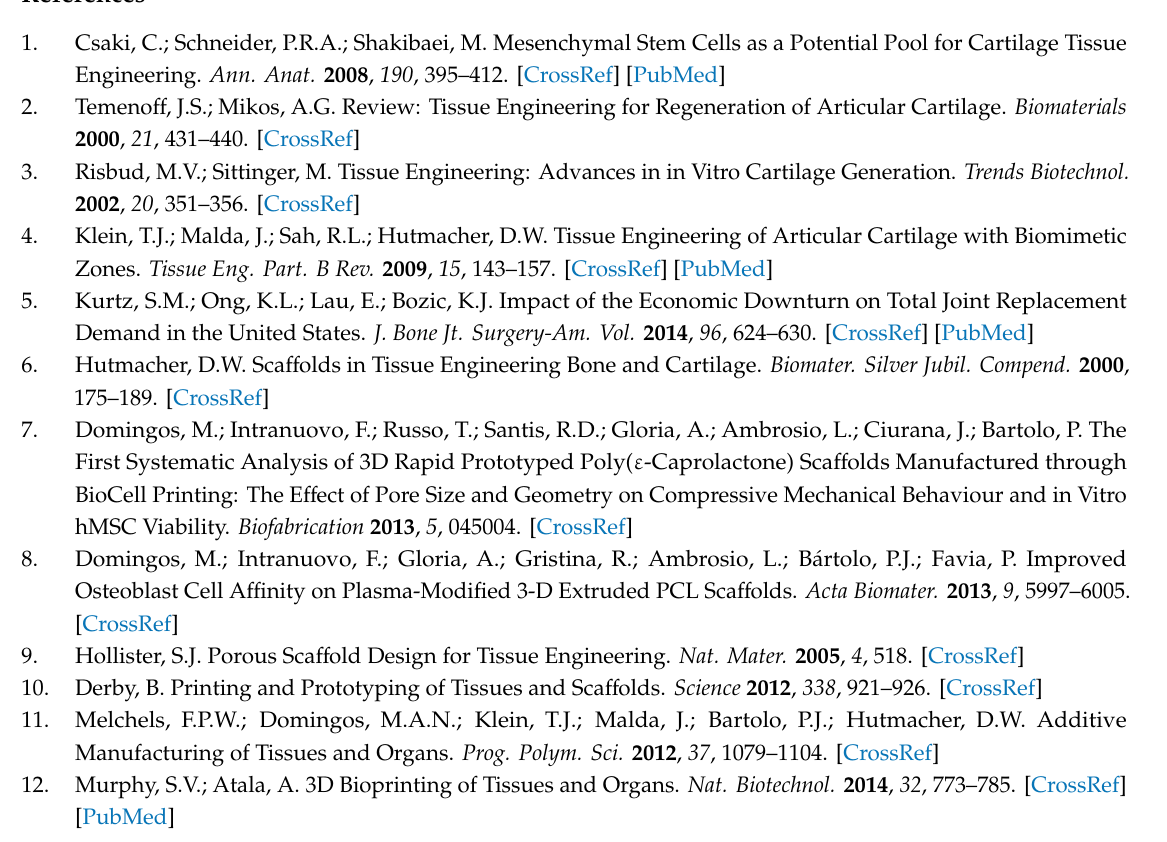
Figure S1: Heat flow curve (2nd heating cycle) of PEU; Figure S2: Heat flow curve (1st heating cycle) of